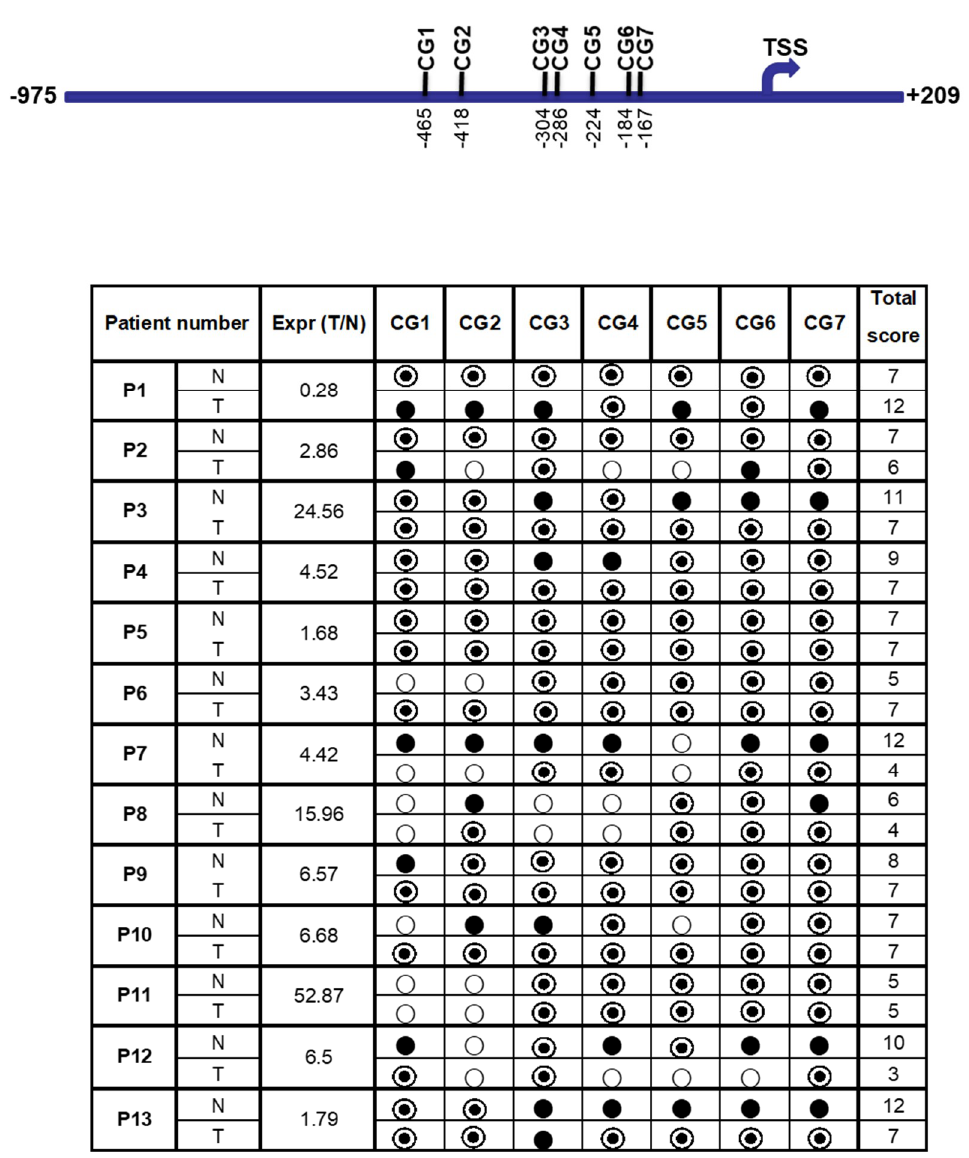
Figure 5. Correlation between the methylation status at the FAT10 promoter and FAT10 transcript expression in HCC patient tissues. The seven CG dinucleotides are schematically represented at the top panel. TSS: Transcription Start Site. The bottom panel shows the correlation between the methylation status and the fold difference in FAT10 transcription expression between the tumor and non‐tumorous liver tissue of each HCC patient. The last column shows the sum of the scores of either the fully methylated (score = 2) denoted by ●, half methylated (score = 1) denoted by ◎ , and unmethylated (score = 0) denoted by ○ .